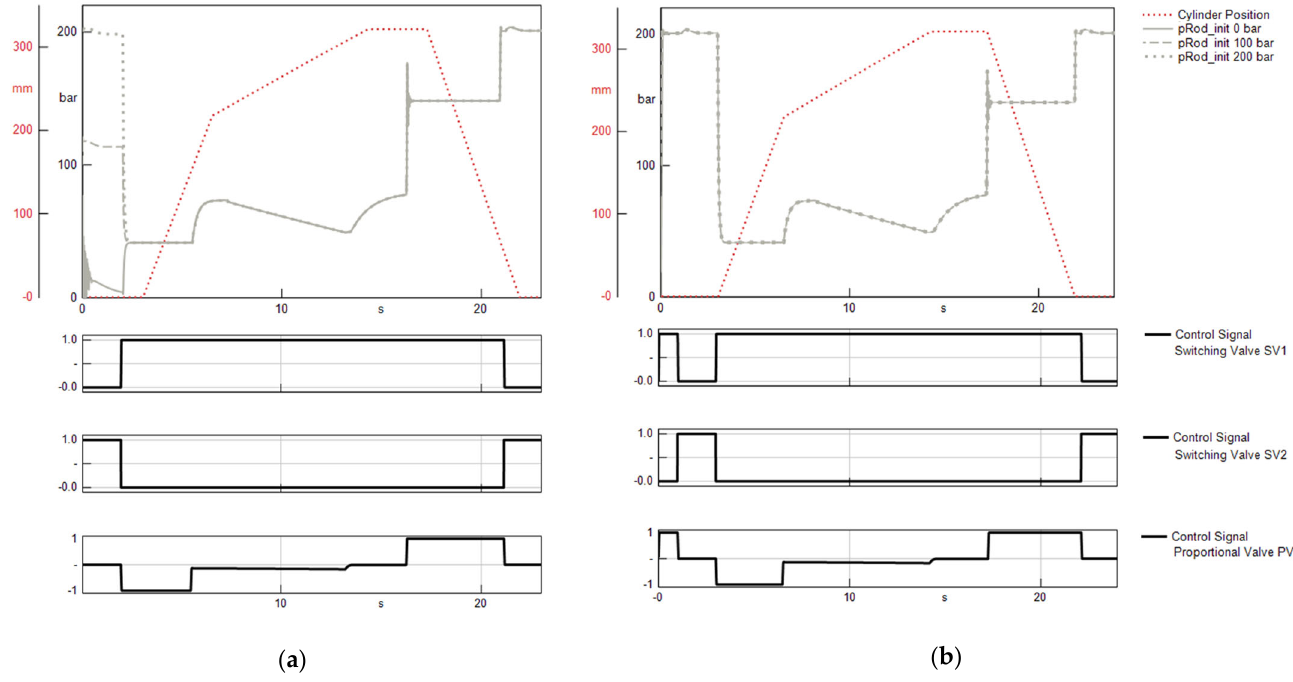
Figure 5. Cylinder position, cylinder pressures and valve control signals simulated under fixed initial conditions while ( a ) starting the simulation with the actual control sequence of the press cycle and ( b ) starting the simulation with the ending sequence of a press cycle prior to the actual control sequence.